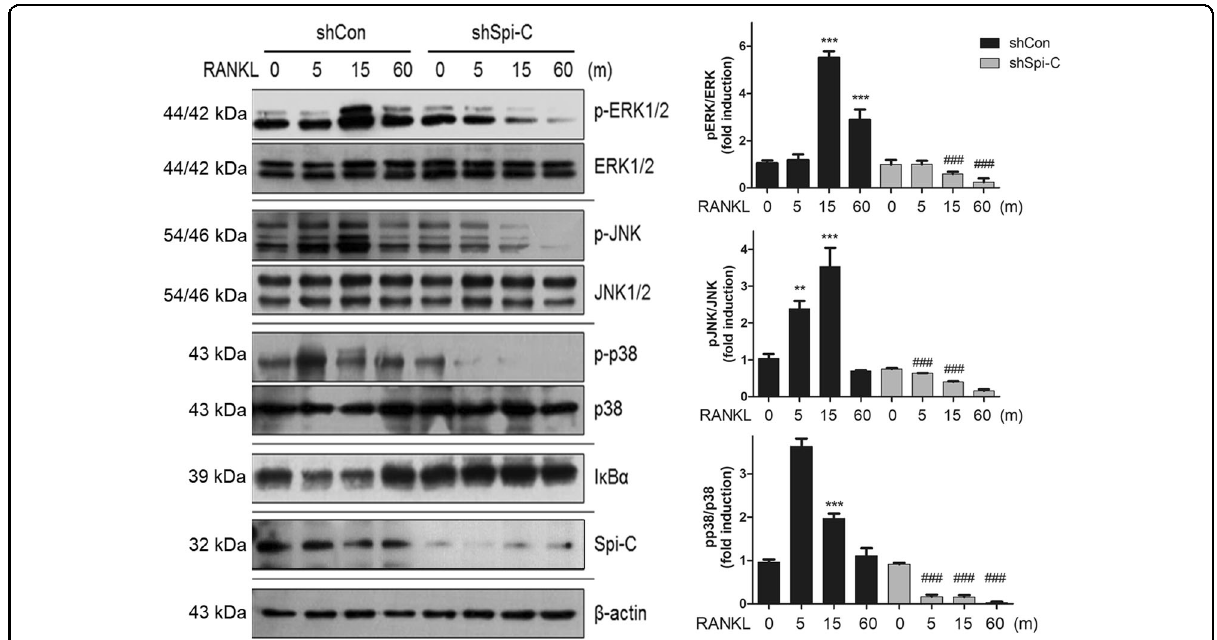
Fig. 7 Decrease in RANKL-mediated NF- κ B and MAPK activation by Spi-C depletion. BMMs were transduced with a control shRNA lentiviral vector (shCon) or Spi-C shRNA expression lentiviral vector (shSpi-C), serum-starved, and incubated with RANKL (200ng/ml) for the indicated times. Then, the cells were subjected to western blot analysis with antibodies speci fi c to p-ERK1/2, ERK1/2, p-JNK, JNK1/2, p-p38, p38, I κ B α , Spi-C, and actin. Actin was used as a loading control (right panels). The protein bands were quanti fi ed using densitometry, and the levels of p-ERK1/2, p-JNK and p-p38 were normalized to the levels of ERK1/2, JNK1/2 and p38, respectively (left panels). ** p <0.005, *** p <0.001 vs. untreated shCon cells and ### p <0.001 vs. RANKL-treated shCon cells.